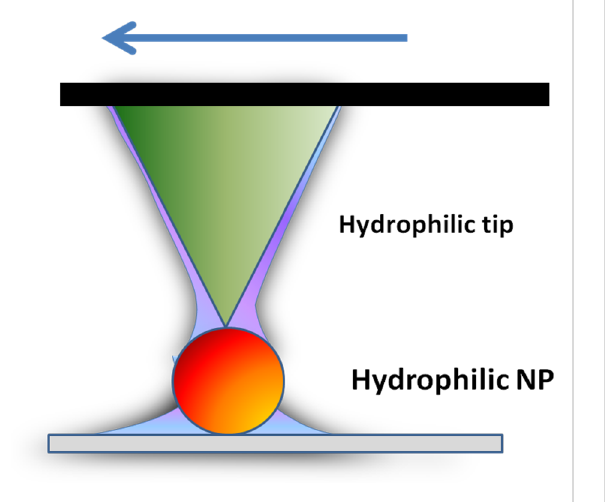
Scheme 2: Formation of two capillary water bridges between hydrophilic tip and particle, and particle and surface.